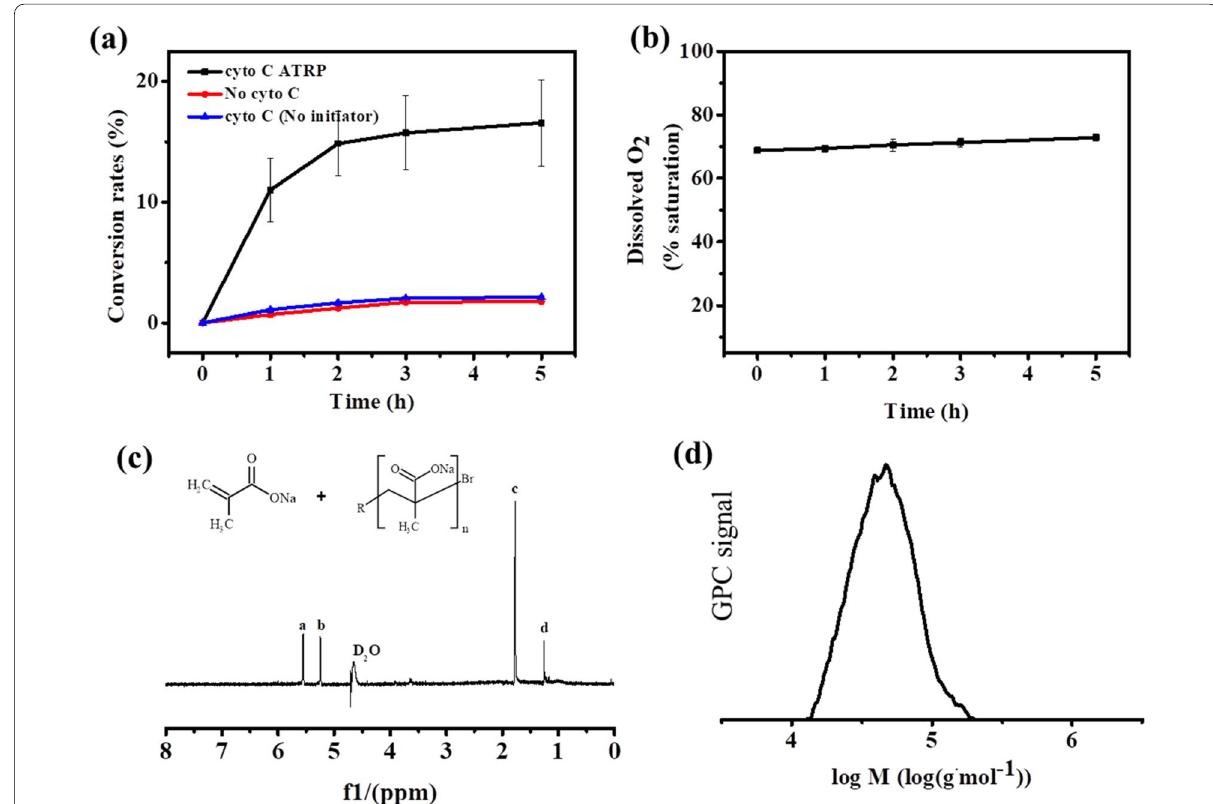
Fig. 2 a Conversion of SMA by cytochrome C catalyzed ATRP under aerobic condition. b Dissolved oxygen (DO) of the aerobic ATRP solution. The DO was presented as the percentage of the oxygen level in solution over the total oxygen level under oxygen saturation condition. c 1 H NMR spectrum of PSMA/SMA mixture synthesized by cytochrome C catalyzed ATRP under aerobic condition. d GPC curve of the PSMA synthesized by cytochrome C catalyzed ATRP under aerobic